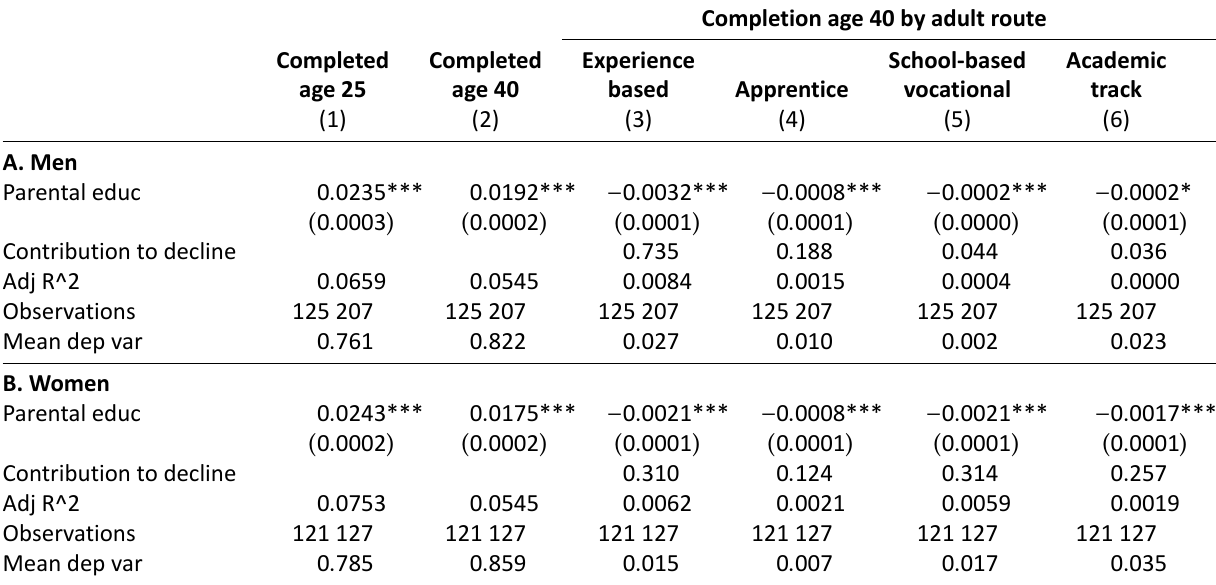
Table 2. Completion of upper secondary education by ages 25 and 40, by gender and by adult route. Effects of parental